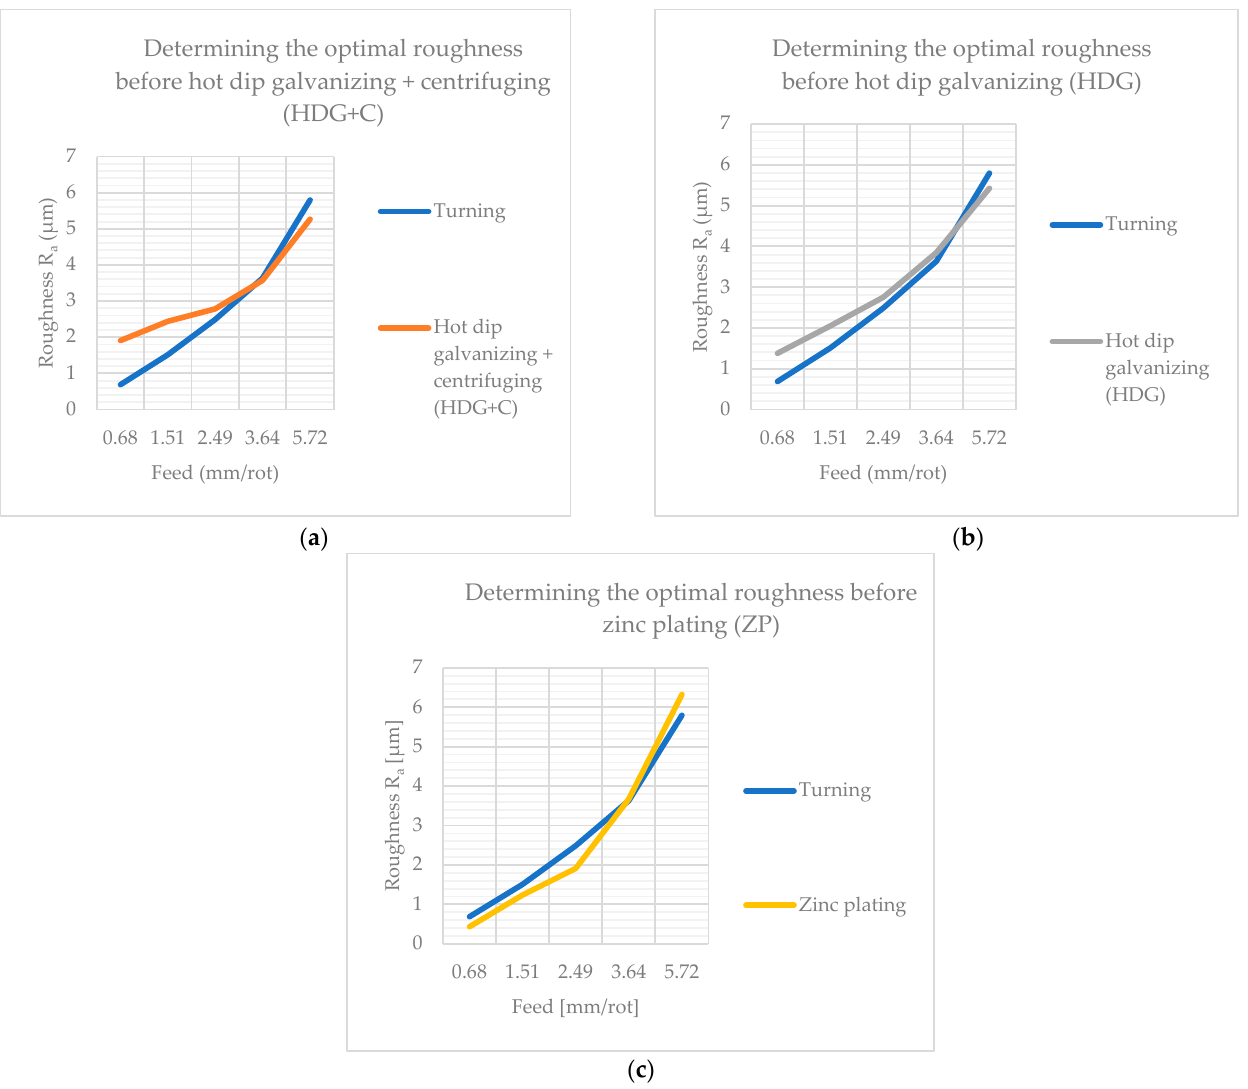
Figure 18. ( a ) Determining the optimal roughness before hot dip galvanizing + centrifuging (HDG+C). ( b ) Determining the optimal roughness before hot dip galvanizing (HDG). ( c ) Determining the optimal roughness before zinc plating (ZP).